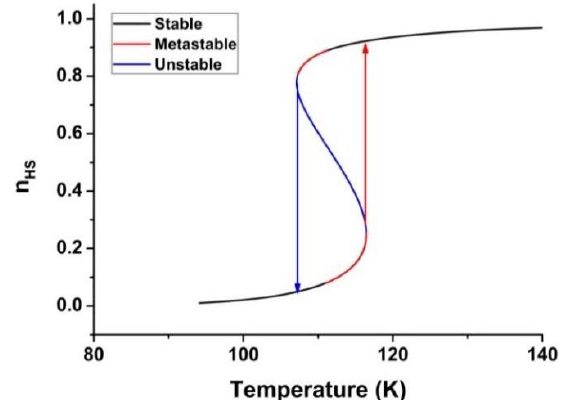
Figure 7. Thermal dependence of the HS fraction showing a hysteresis loop with respective upper and lower transition temperatures, 116 and 106 K. Stable, metastable, and unstable regions are plotted with black, red, and blue lines, respectively. The parameters values are: ∆ = 394 K, g = 1097, and J = 155